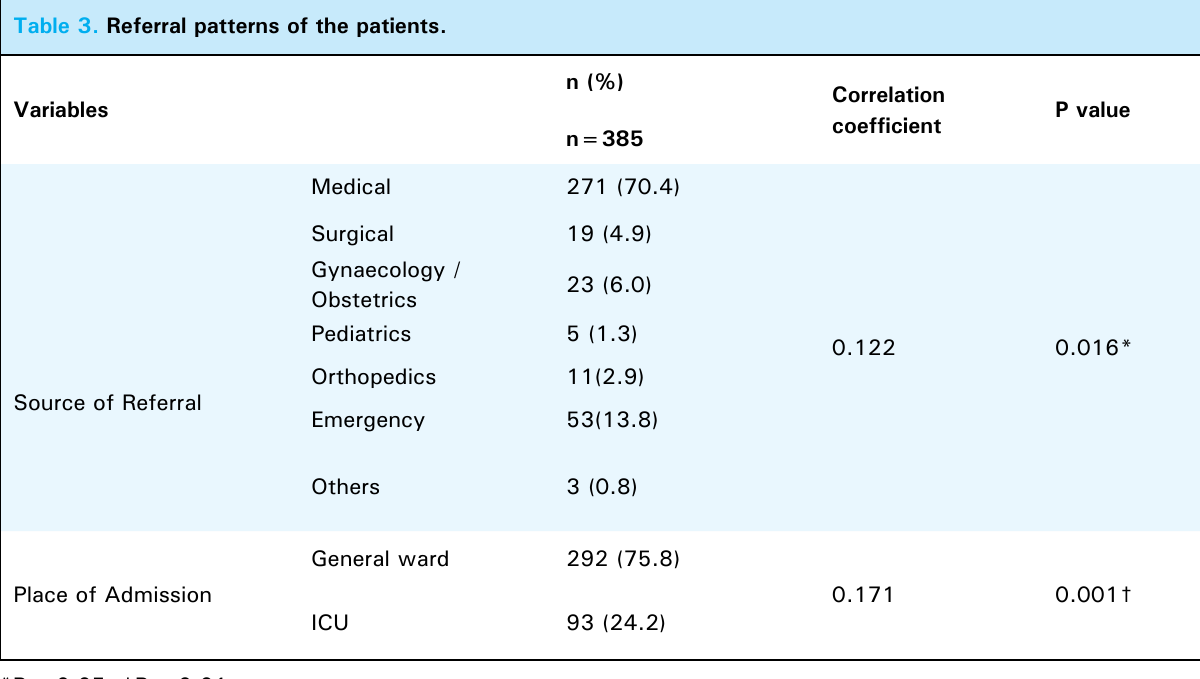
Table 3. referral patterns of the patients.